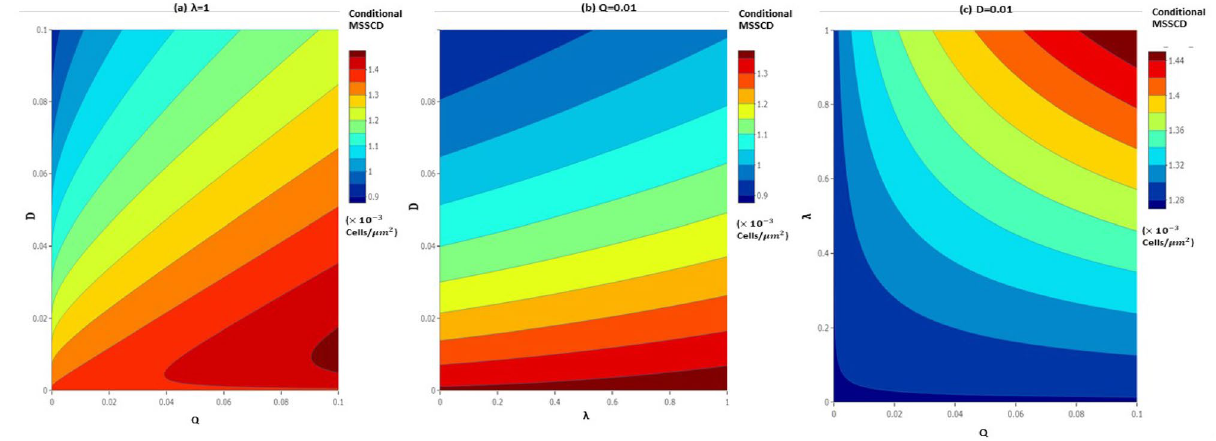
Figure 9. The change in the conditional MSSCD value for different noise strengths and correlation strength using the parameters estimated for seeding 1: ( a ) the conditional MSSCD values in D with highest correlation ( (cid:31) conditional MSSCD values in Q